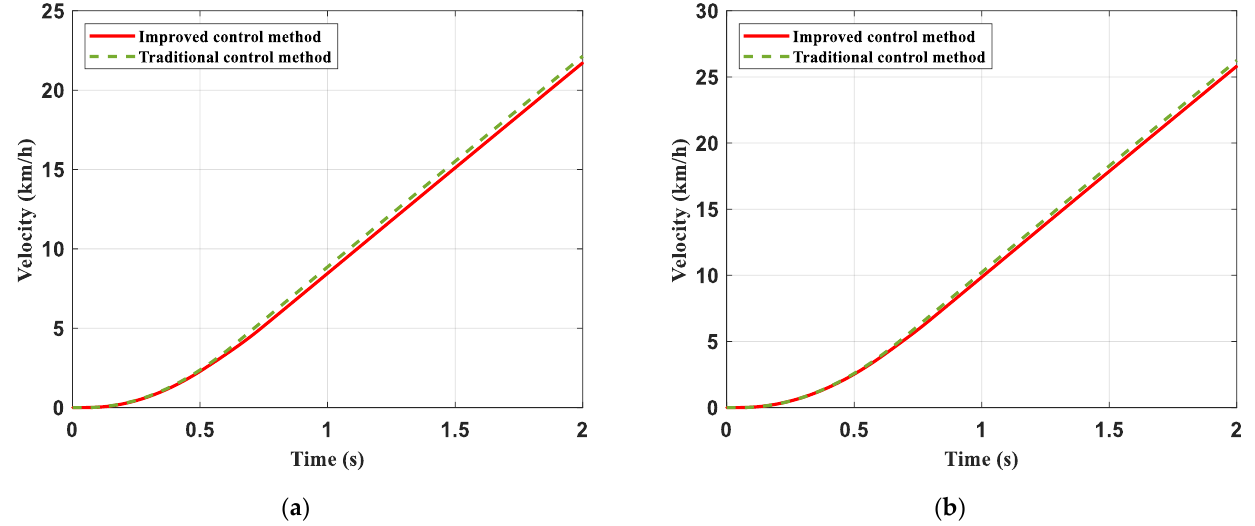
Figure 11. The vehicle velocity with different control methods. ( a ) Slowly starting; ( b ) Quickly start- ing.